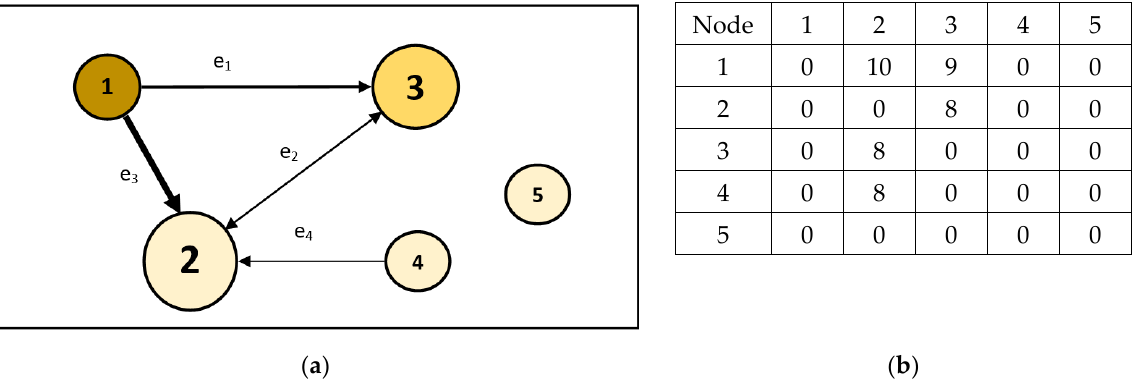
Figure 2. ( a ) Weighted and directed network constructed from a questionnaire filled by five students. The size of the node represents its weighted indegree value and the thickness of the edge represents the edge weight. The highest achiever (highest marks) is represented by the darkest node, while the lower achievers are represented by the lighter colored nodes, respectively. ( b ) The adjacency matrix, 𝐴 𝑖𝑗 , representing the network constructed from the student network in ( a ).